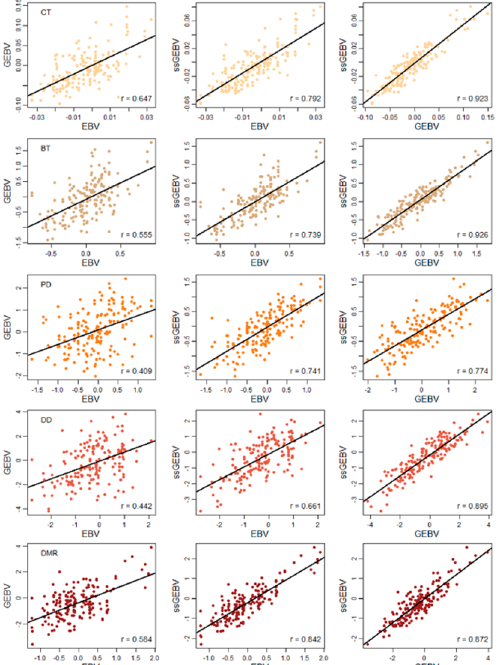
Figure 1. Correlations of estimated breeding values of the test set in the forward prediction scenario. CT: Coiled tail; BT: Bent tail; PD: Proximal droplet; DD: Distal droplet; DMR: Distal midpiece reflex. Each row represents a trait (with the same color).